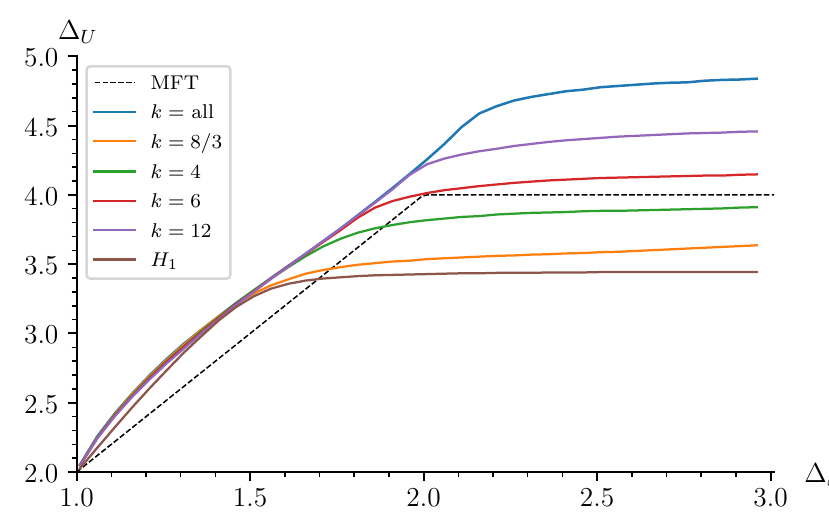
Figure 6 . Upper bound on the dimension ∆ U of the first unprotected operator in the ϕ × ¯ ϕ and M × M OPEs as a function of the dimension of the chiral operator ∆ ϕ . The central charge c is not fixed to a particular value. In the top blue curve, the flavor central charge k is also unfixed, while it takes values k = 8 / 3 , 4 , 6 , 12 in the curves below it. For the brown curve, both central charges are fixed to the values of the H 1 theory c = 1 , k = 8 . The black dashed curve is the mean field 2 3 theory value (4.4). All results are computed with Λ = 24